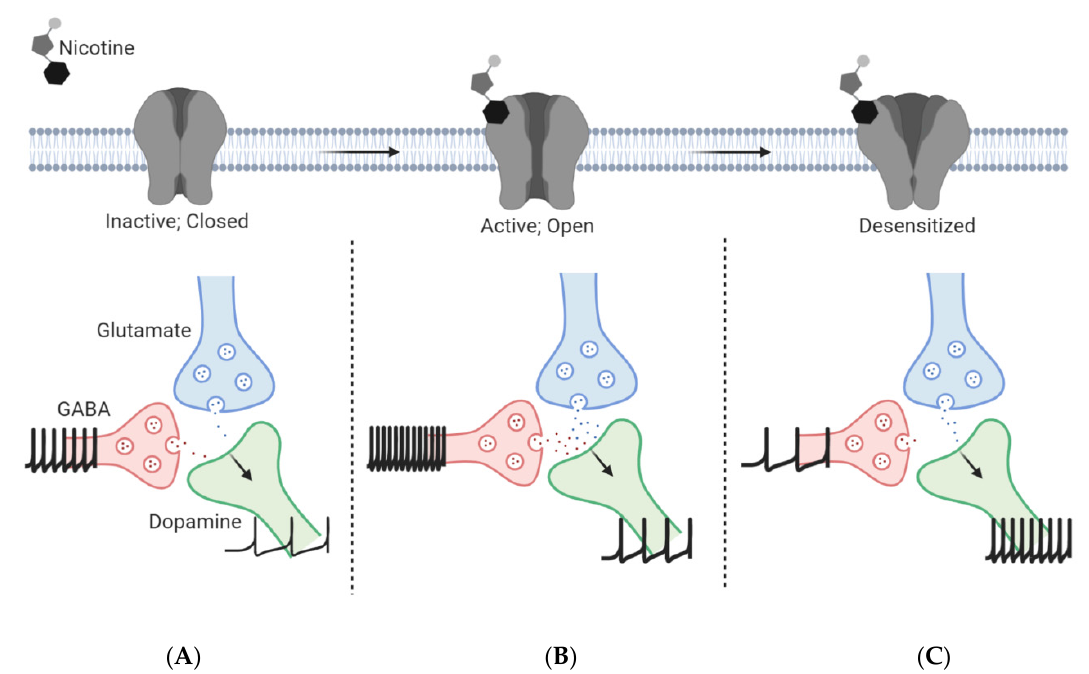
Figure 2. Involvement of ventral tegmental area (VTA) neuron types in nicotine reward and reinforcement. ( A ) In the absence of nicotine, glutamate and GABA inputs to VTA dopamine neurons modulate activity of the mesolimbic reward pathway. ( B ) Acute nicotine on α 7 and α 4 β 2 nAChRs elicits enhanced glutamatergic and GABAergic firing, respectively, onto VTA dopamine neurons, resulting in a net enhancement of dopaminergic neuron firing and subsequent dopamine release. ( C ) Following long-term nicotine use, α 4 β 2 nAChRs desensitize rapidly with acute exposure to nicotine and result in reduced GABAergic firing while glutamatergic firing is enhanced to stimulate burst firing of dopaminergic neurons (see also Table 1 for additional details).